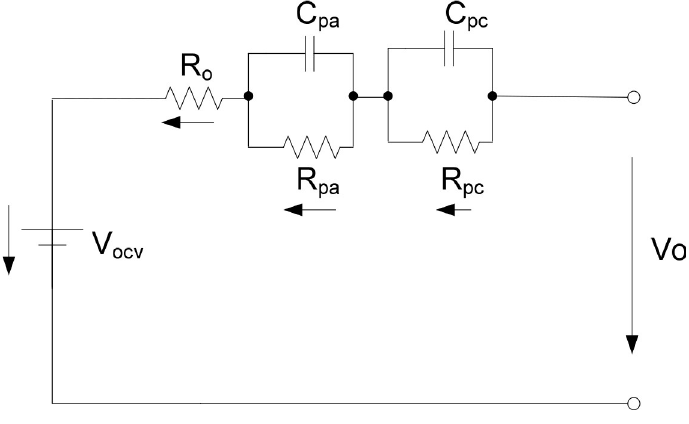
Figure 8. Equivalent circuit model of the